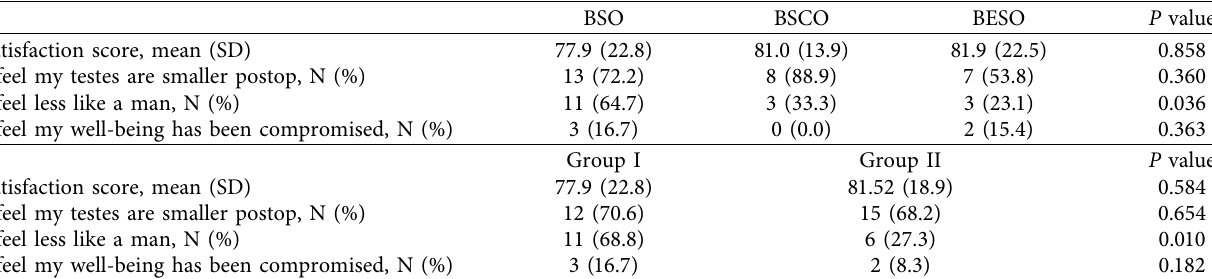
Figure 8: Complications of the patients in the different orchidectomy groups. Table 6: Comparison of patient satisfaction with surgery